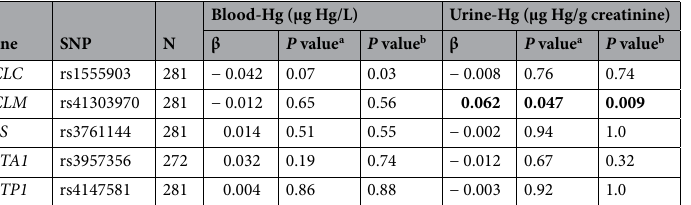
Table 3. Association of genetic variants in glutathione-related genes with Hg levels in blood and urine. Statistically significant association are shown in bold (P value < 0.05). Each SNP was examined using multivariable linear regression models assuming additive models of inheritance adjusted by exposure status, age, sex, eGFR, and hair-Hg levels (µg Hg/g hair). a P value from a generalized linear model. b Empirical P value determined based on 5000 permutations from a generalized linear